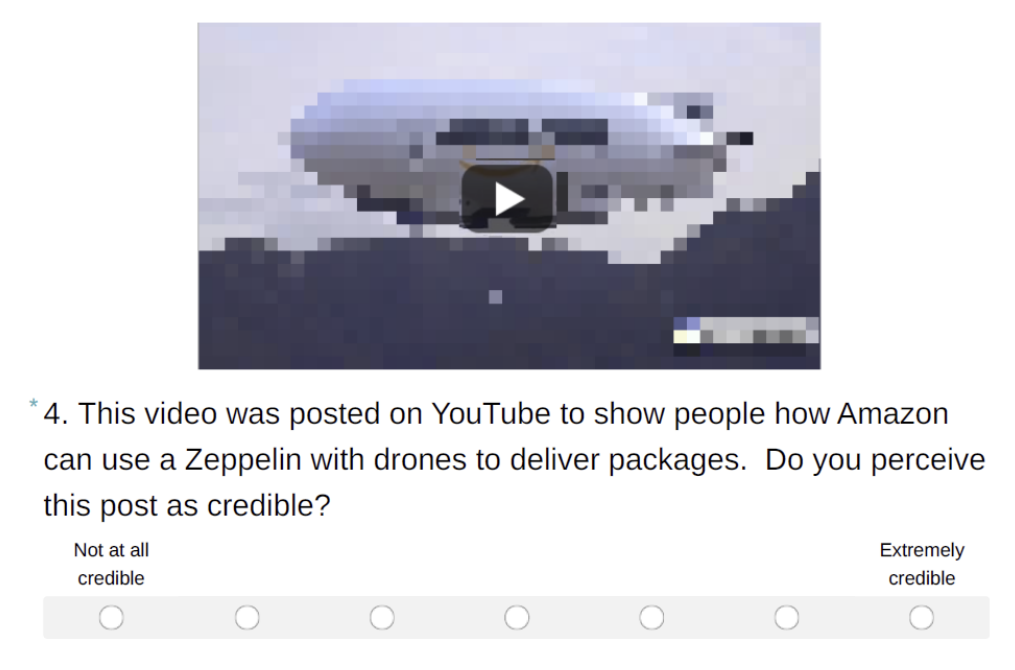
Figure A1. Viral, true example.